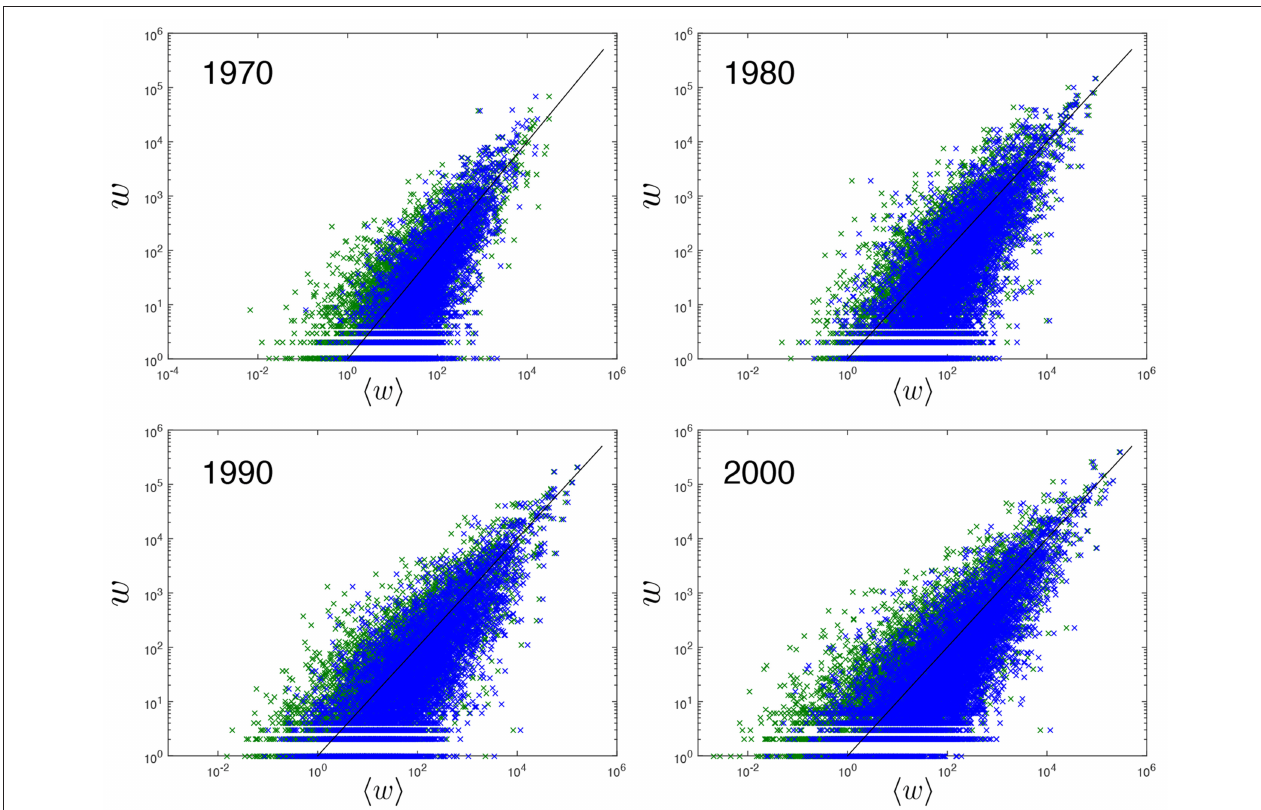
FIGURE 2 | Empirical non-zero trade flows vs. the corresponding expectations under the traditional Gravity Model and the Enhanced Gravity Model. Log-log plot comparing the empirical volume ( y -axis) of all non-zero bilateral trade flows in the ITN with the corresponding (conditional) expected volume ( x -axis) predicted by the Gravity Model defined in Equation (1) (green, parameters estimated as reported in Table 1 ) and by the Enhanced Gravity Model defined in Equations (4) and (27) (blue, parameters estimated as reported in Table 2 ). Top left: year 1970, top right: year 1980, bottom left: year 1990, bottom right: year 2000. The black line is the identity line corresponding to the ideal, perfect match that would be achieved if the empirical weights were exactly equal to their (conditional) expected values, i.e., in complete absence of randomness.